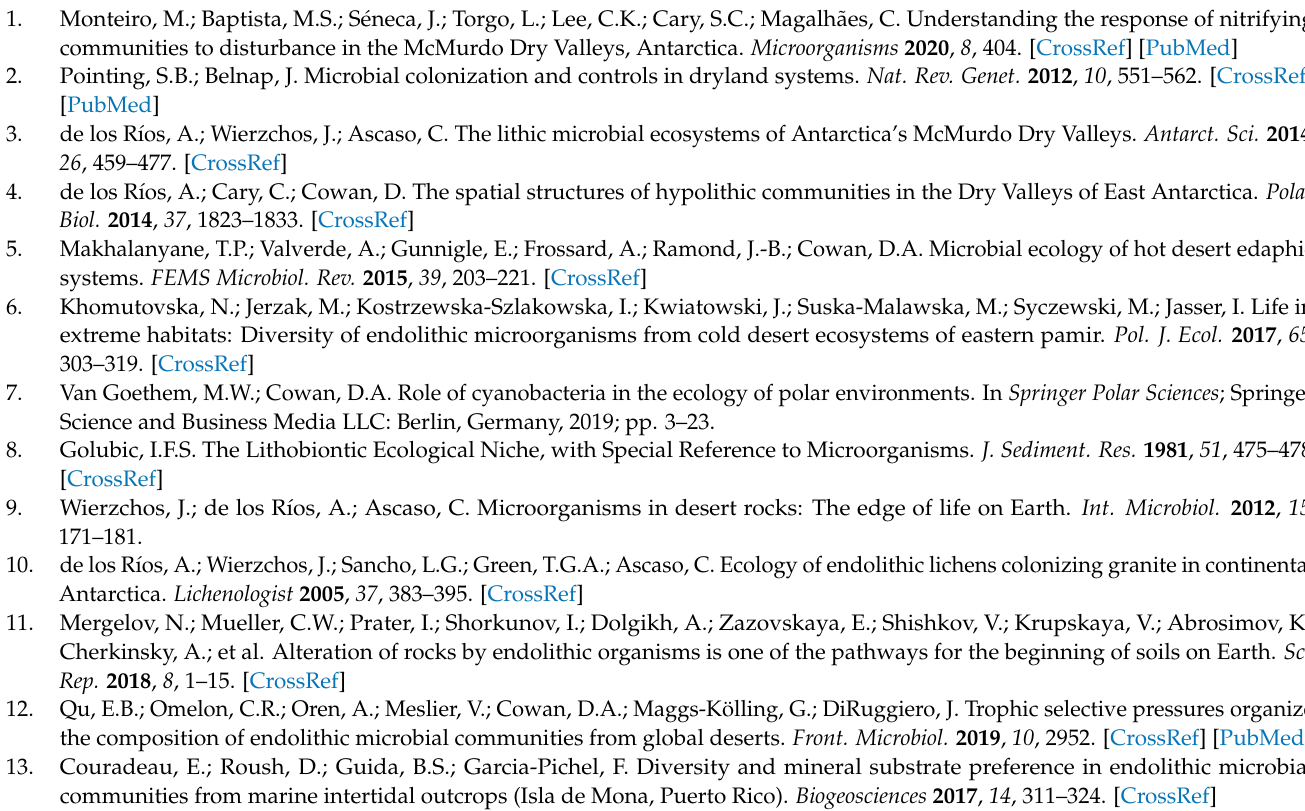
Table S2. Comparative analysis of Pamirian endolithic communities using culture-dependent and culture-independent methods. Table S3. Scripts used for analyses of sequences in QIIME2 (version 2020.2). The tree is available online under the link